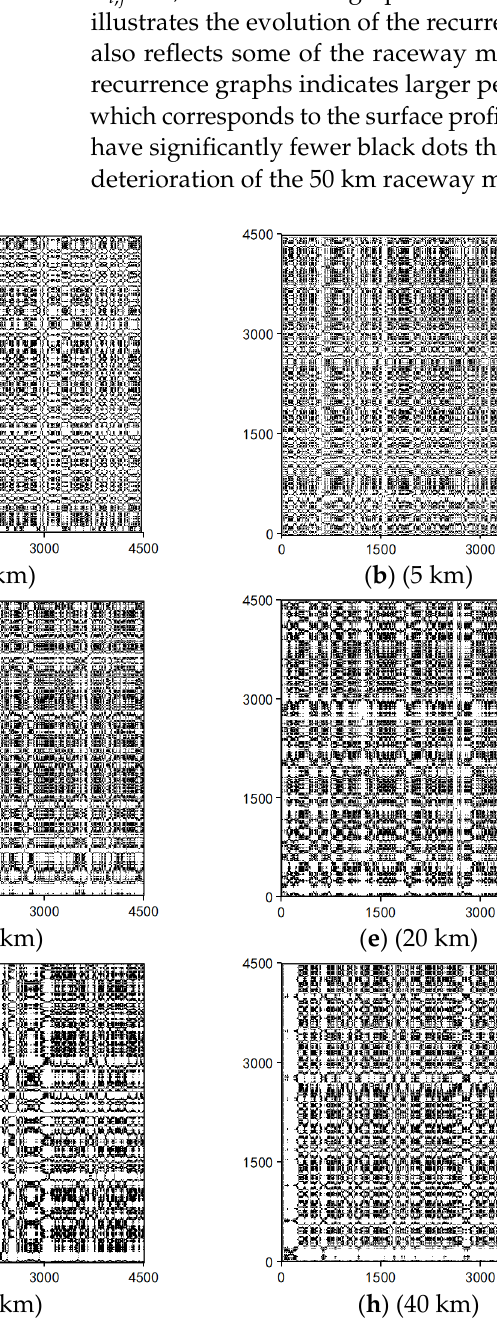
Figure 13. Recurrence plots of surface profiles during wear. ( a ) (0 km), ( b ) (5 km), ( c ) (10 km), ( d ) (15 km), ( e ) (20 km), ( f ) (25 km), ( g ) (30 km), ( h ) (40 km), ( i ) (50 km).